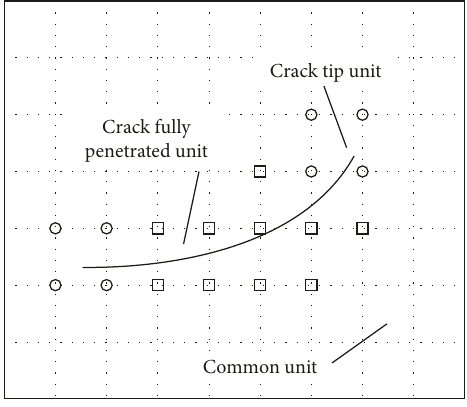
Figure 1: Analysis domain including a